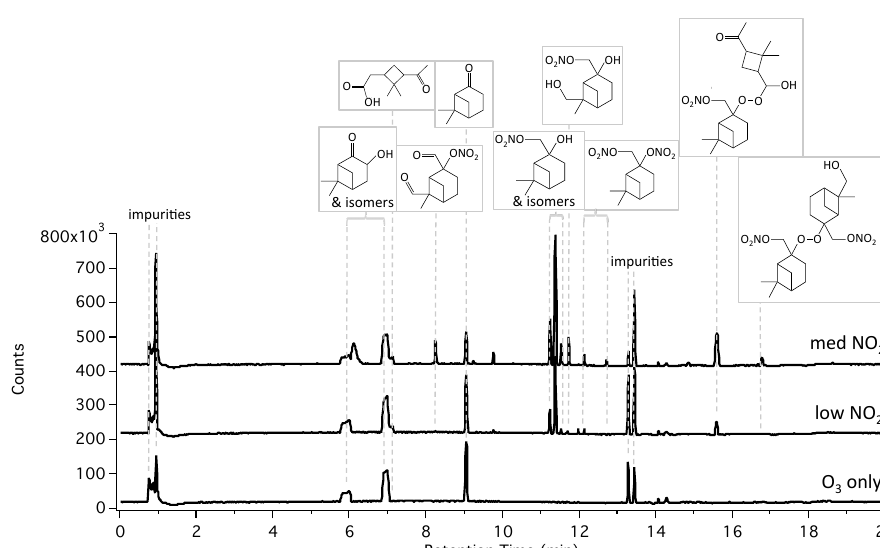
Figure 6. Comparison of chromatograms from HPLC-ESI-MS samples of SOA derived from β -pinene ozonolysis with 0 (bottom), 530 (middle), and 910ppb NO 2 (top). Chromatograms are annotated with speculative structures corresponding to the assigned molecular formulae of the most intense peaks. Proposed structures are listed in Table S3 based on products observed in other studies.